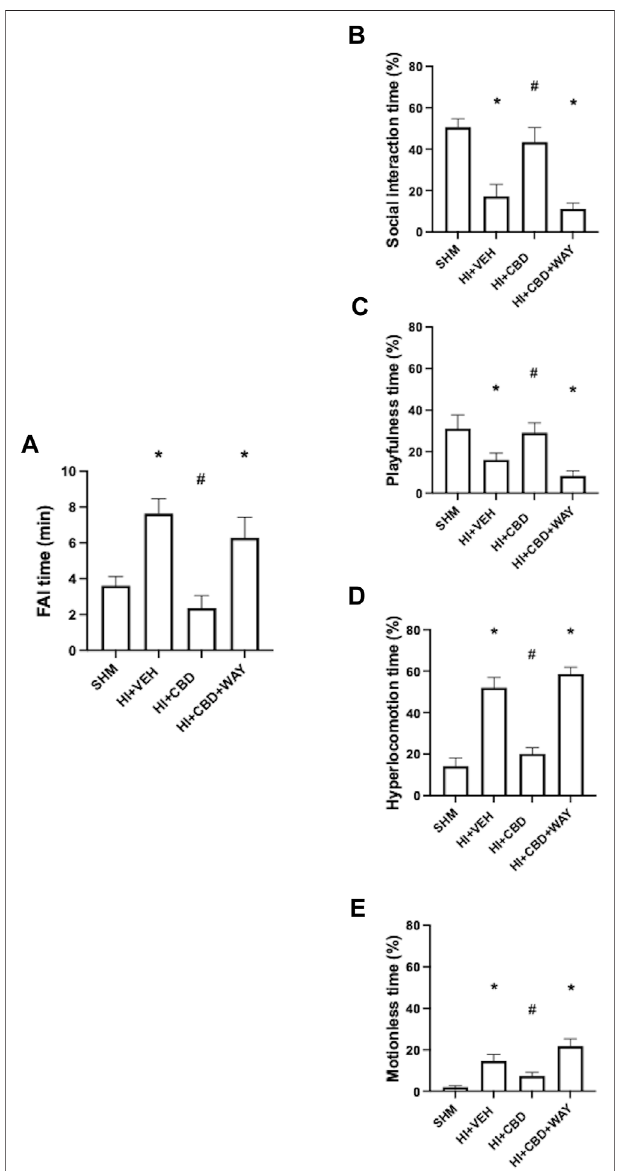
FIGURE 2 | Neurobehavioral assessment 72 h after hypoxic – ischemic insult in piglets treated with vehicle (HV), cannabidiol (HC), and WAY 100635 (HCW). Non-hypoxic – ischemic piglets served as controls (SHM). (A) Time spent fi ghtingagainst immobilization(FAI)( left ).Relative time ( right )spent in (B) social interaction, (C) playfulness, (D) hyperlocomotion, and (E) motionless periods. Bars represent the mean (SEM) of 6 – 12 experiments. ( p ) p < 0.05vs.SHMand(#) p < 0.05vs.HVbyANOVAwithHolm – Š idacktestfor multiple comparisons.